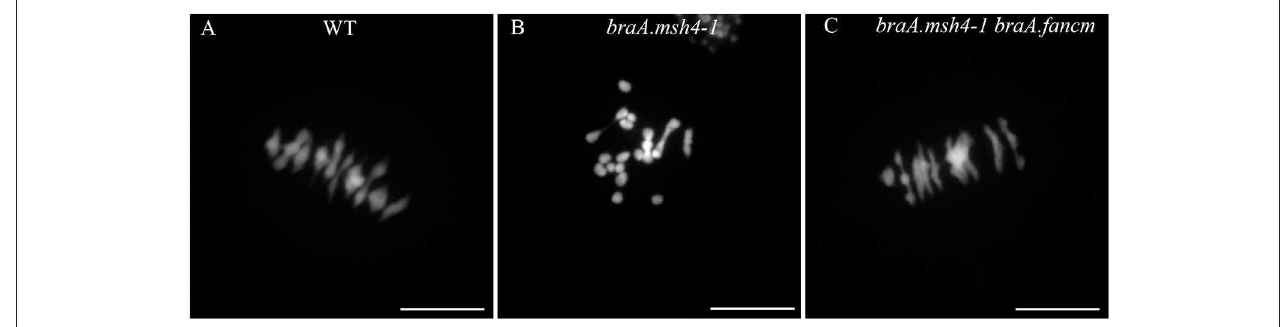
FIGURE 2 | Restoration of bivalent formation in the double mutant braA.msh4-1 − / − braA.fancm- − / − (A) During metaphase I in WT B. rapa , 10 bivalents and no univalent are formed. They are all aligned on the metaphase plate. (B) In the single braA.msh4-1 − / − mutant, only a few bivalents are formed, most of the chromosomes remain as univalents. (C) Metaphase I in the double mutant braA.msh4-1 − / − braA.fancm- − / − is reminiscent of metaphase I in WT B. rapa, mostly bivalents are formed, only ∼ 0.5 univalent pair is found on average per cell. Scale bar = 10 µ m.